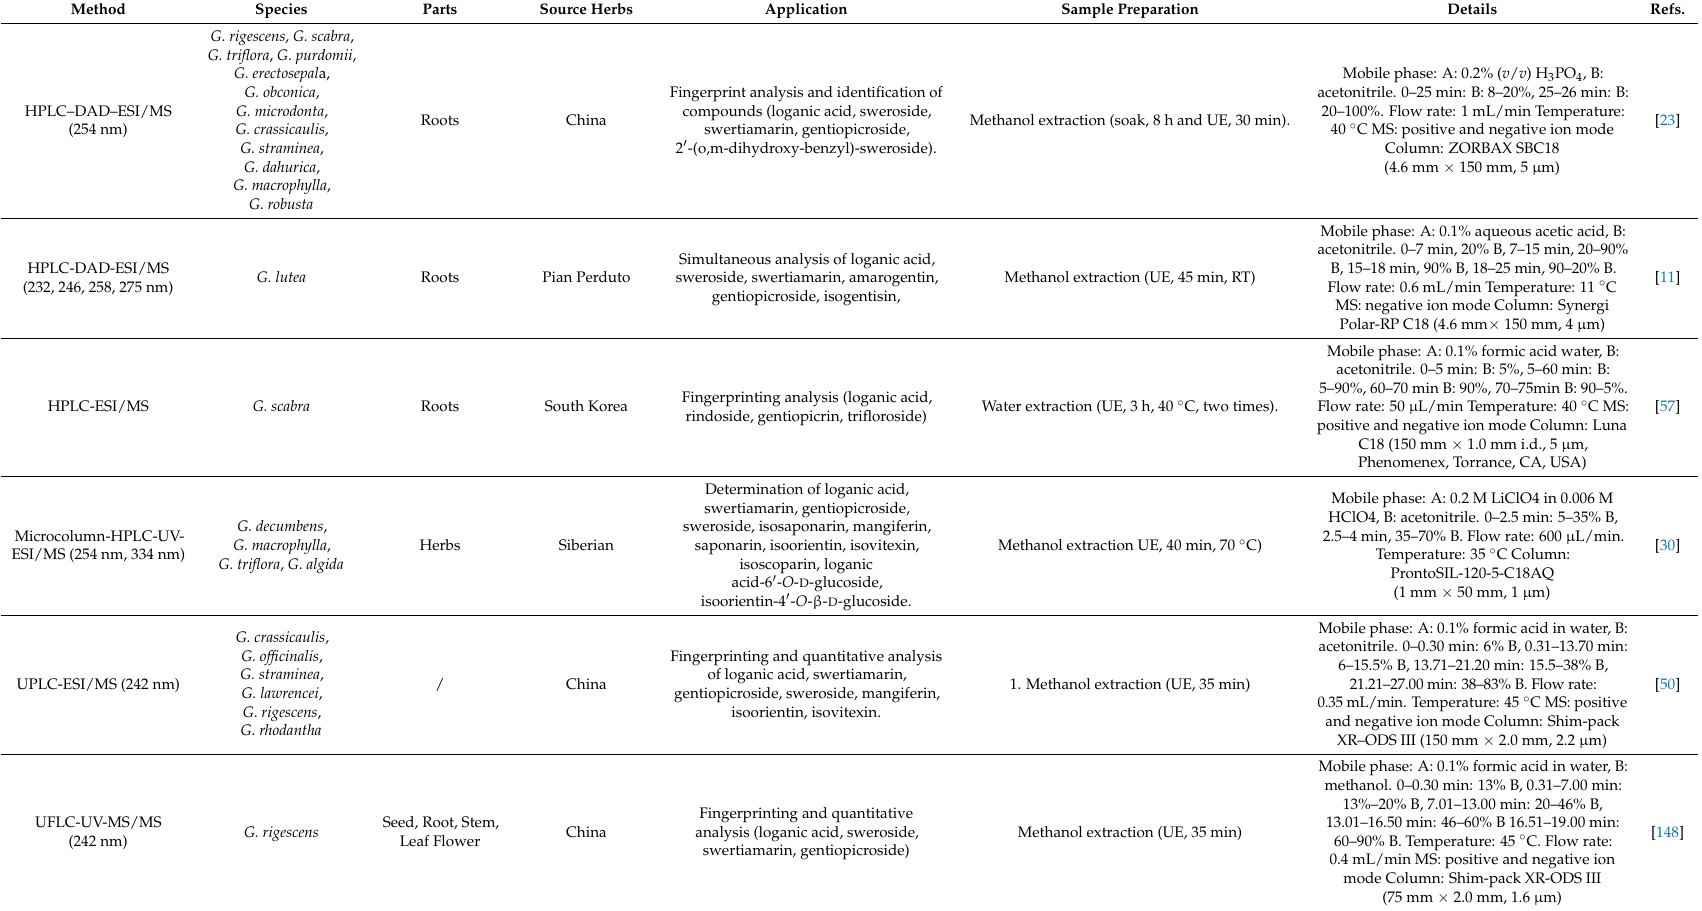
Table 4. Cont. Application Sample Preparation Details Refs.